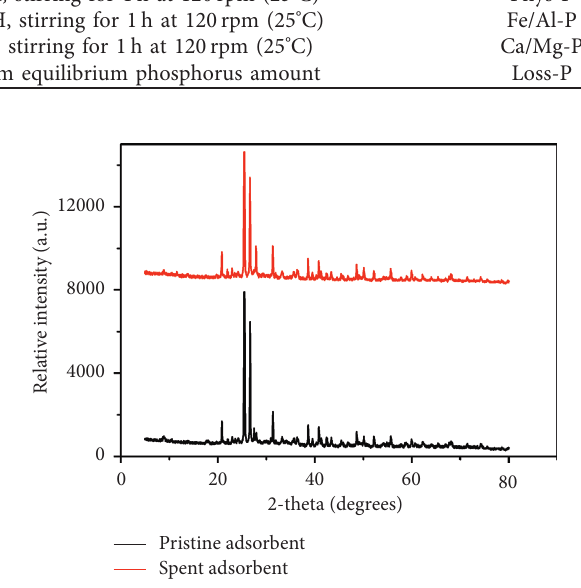
Figure 2: XRD spectra of adsorbent before and after